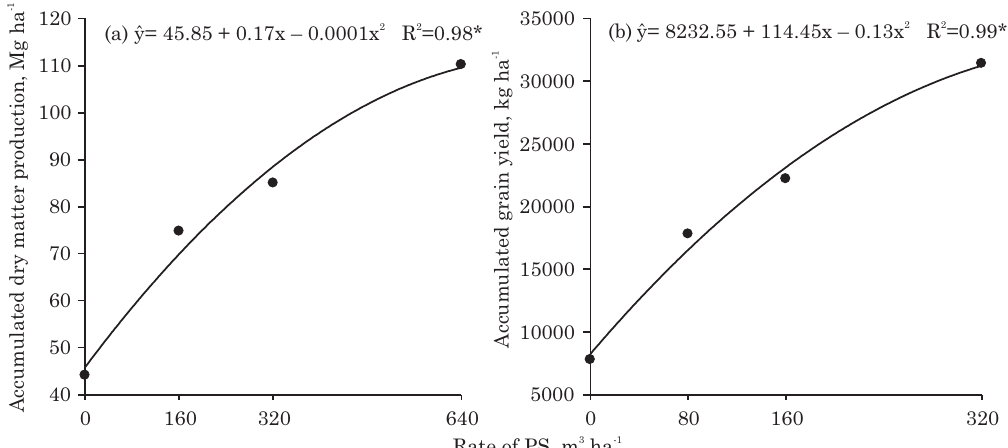
Figure 3. Accumulated dry matter production of the aerial part of cover crops, maize and common bean (a), and accumulated grain yield of black bean and maize in the growing seasons from 2002 to 2007 (b), on soil fertilized with accumulated amounts of pig slurry (PS). * indicates that the coefficients of determination were significant by the F test at 5